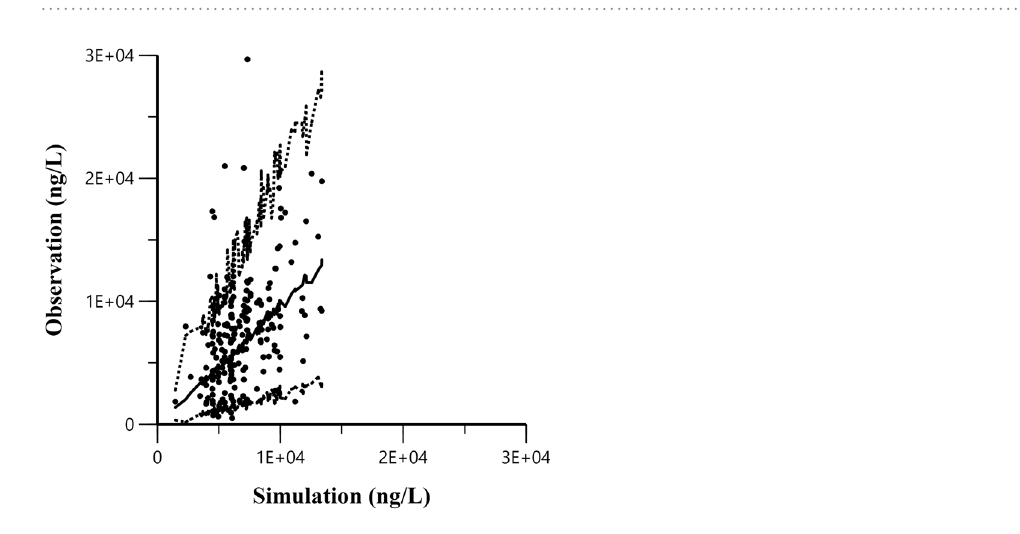
Figure 5. Visual predictive check plot of the final population model for drug concentration. Each dot means a data point; dotted lines are 5 th and 95 th percentiles and solid line are predicted 50 th percentile. The area between the 5 th and 95 th percentiles represents the 90% prediction